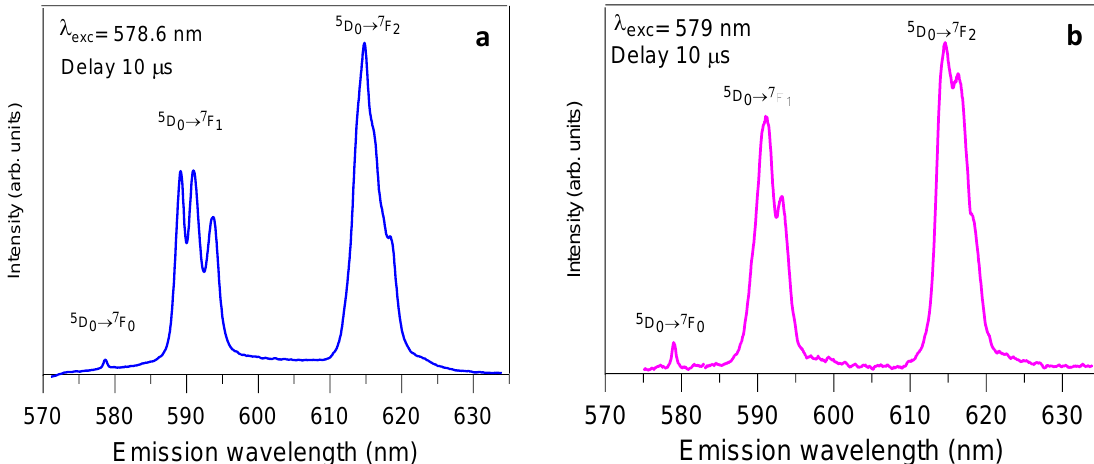
Figure 8. Time-resolved fluorescence line-narrowed emission spectra of the 5 D 0 → 7 F 0,1,2 transitions of Eu 3+ ions measured at 9 K at a time delay of 10 µs after the laser pulse under an excitation at ( a ) 578.6 nm and ( b ) 579 nm, respectively, for the 80SiO 2 -20(1.5Eu 3+ : NaGdF 4 ) powders heat-treated at 450 °C for 5 h.